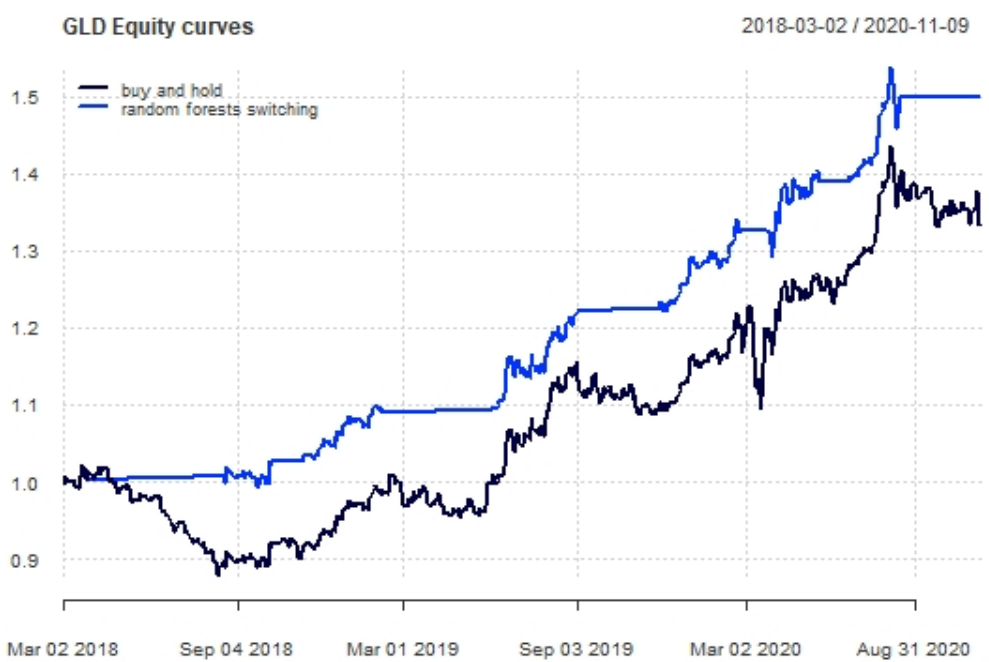
Figure 12. This figure shows GLD equity curves comparing the buy and hold portfolio with the random forests switching portfolio.